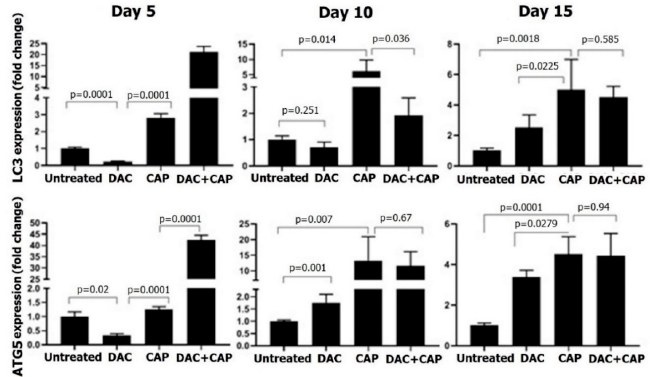
Figure 8. LC3 and ATG5 expression in melanoma samples subjected to CAP or DAC mono or combination therapy. Shown are results for LC3 and ATG5 in tumor tissue lysates collected at days 5, 10, and 15. Real-time PCR was performed using GAPDH as a housekeeping control gene. Altered gene expression is shown as fold changes referring to untreated control cells. The results are representative of three mice per time point. Statistical analysis was performed using one-way ANOVA with Tukey’s post hoc test with the untreated normalized control.